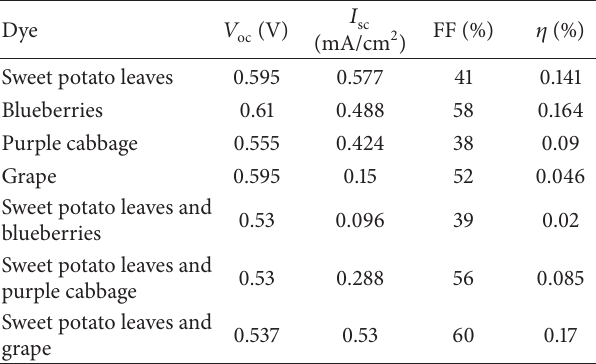
Figure 5: The photocurrent-voltage curves for natural dyes at a weight concentration of 20%. Table 1: The performance of DSSCs using natural dye at a weight concentration of